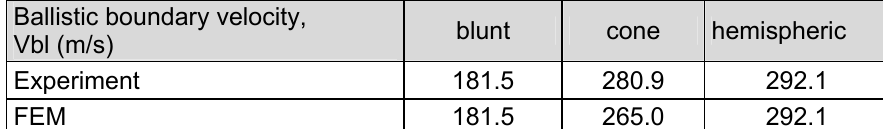
Table 4 – Ballistic boundary velocity (Vbl) for three different projectiles Таблица 4 – Баллистическая граничная скорость (Vbl) трех различных видов